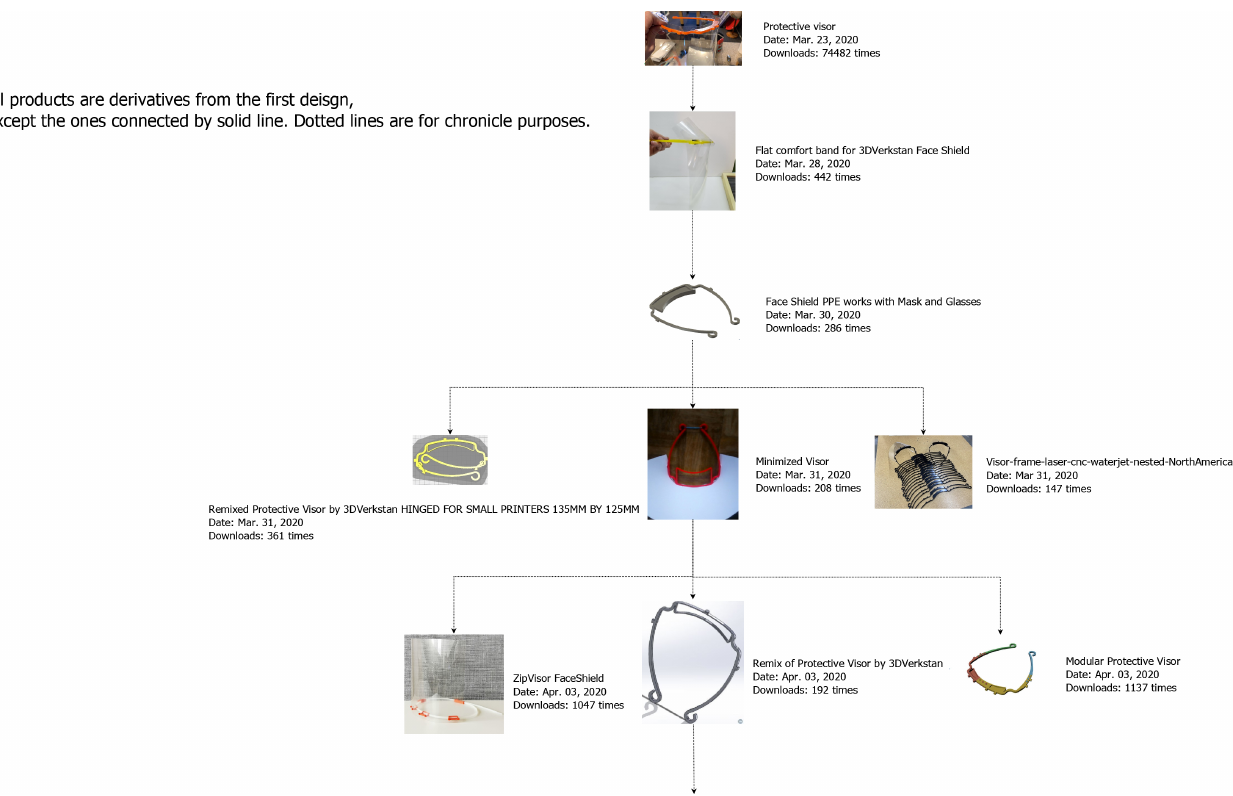
Figure A1: Derivatives of Cederberg’s face shield design on YouMagine part